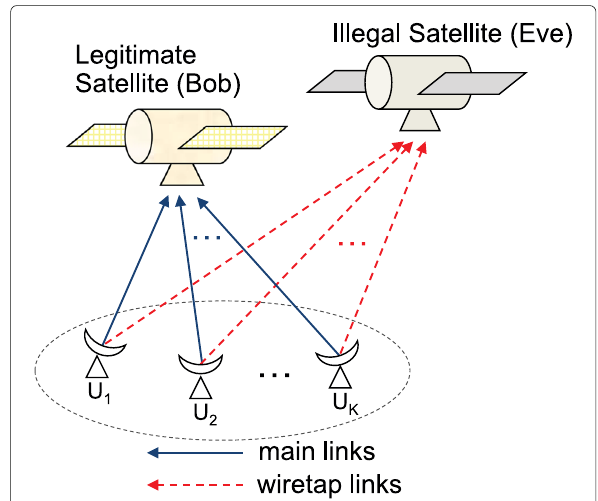
Fig. 1 Model of quasi-static Rayleigh fading homogeneous multiple access wiretap channel with K earth stations, one legitimate